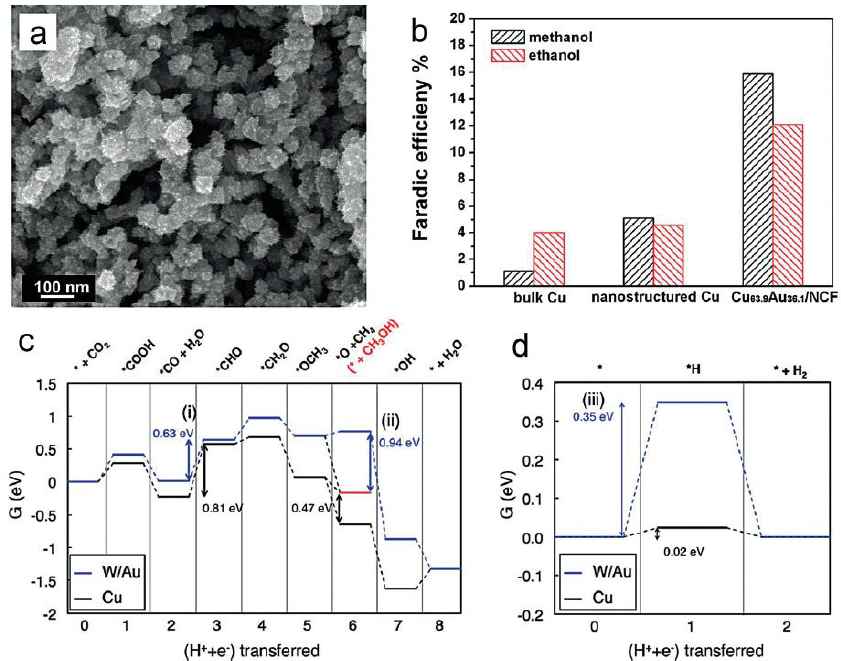
Figure 6. ( a ) SEM image of CuAu sample deposited on nanoporous Cu film; ( b ) Faradaic efficiency of methanol and ethanol on different electrodes. Adapted with permission from Ref. [49]. Copyright 2015, Elsevier; ( c ) Free energy diagram for the CO 2 electroreduction to CH 4 or CH 3 OH (shown in red) and ( d ) Free energy diagram for the H 2 evolution reactions at zero electrode potential for Cu (black) and W/Au (blue). Adapted with permission from Ref. [50]. Copyright 2014, American Chemical Society.